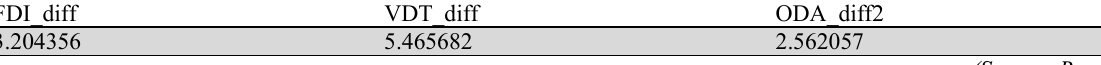
VIF coefficients of independent variables